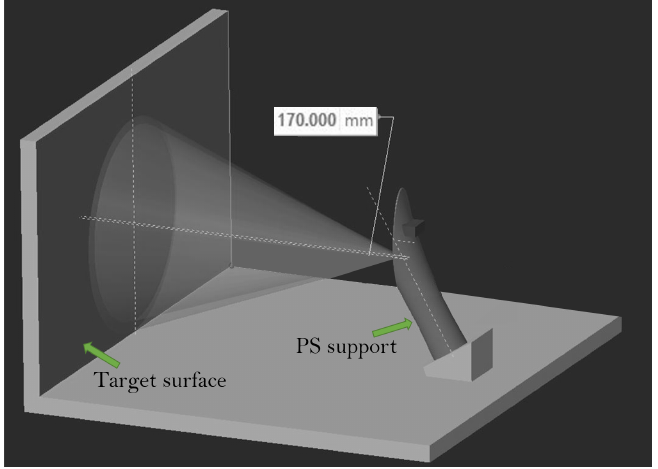
Figure 10. PS calibration setup.